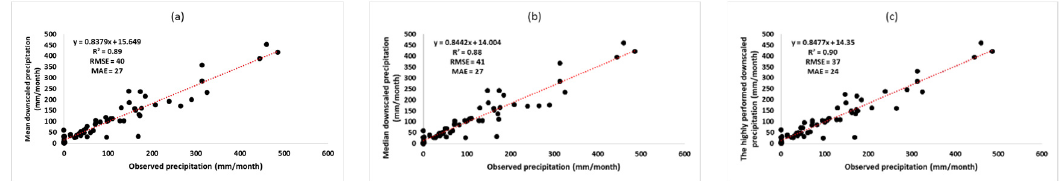
Figure A1. Monthly validation results of the ensemble mean ( a ), ensemble median ( b ), and the highly performed ( c ) monthly downscaled TRMM by disaggregation using ANN algorithm and NDVI, EVI, and LAI vegetation indices, 2018.